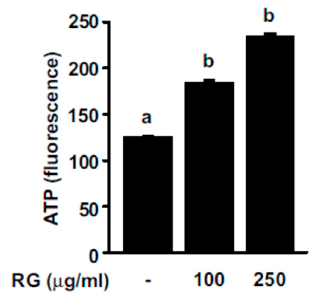
Figure 2. Effects of RG on ATP levels in C2C12 myoblasts. C2C12 cells were induced to differentiate for 2 days, and then cells were treated with 100 or 250 μ g/mL of RG for 24 h. ATP levels were measured by ATP determination kit. Bars with different letters mean significant differences from each other (* p < 0.05).